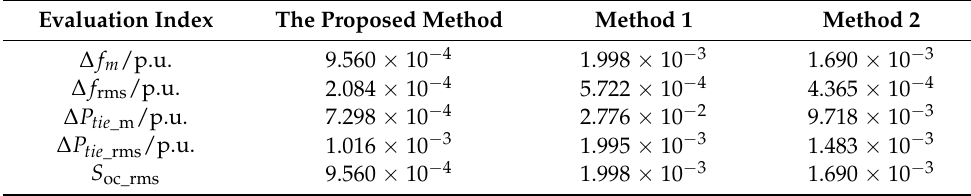
Table 3. Frequency regulation evaluation index under step disturbance. Evaluation Index The Proposed